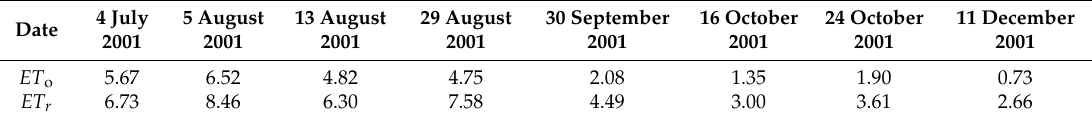
Figure 5. Daily evapotranspiration map for the days of satellite overpasses based on the Operational Simplified Surface Energy Balance (SSEBop) model. Table 3. Area weighted average (81,921 pixels) short grass reference ET ( ET o ) from global data assimilation system and alfalfa reference ET ( ET r ) from weather station data for the day of satellite overpasses. Both ET o and ET r values are in mm·day − 1 .